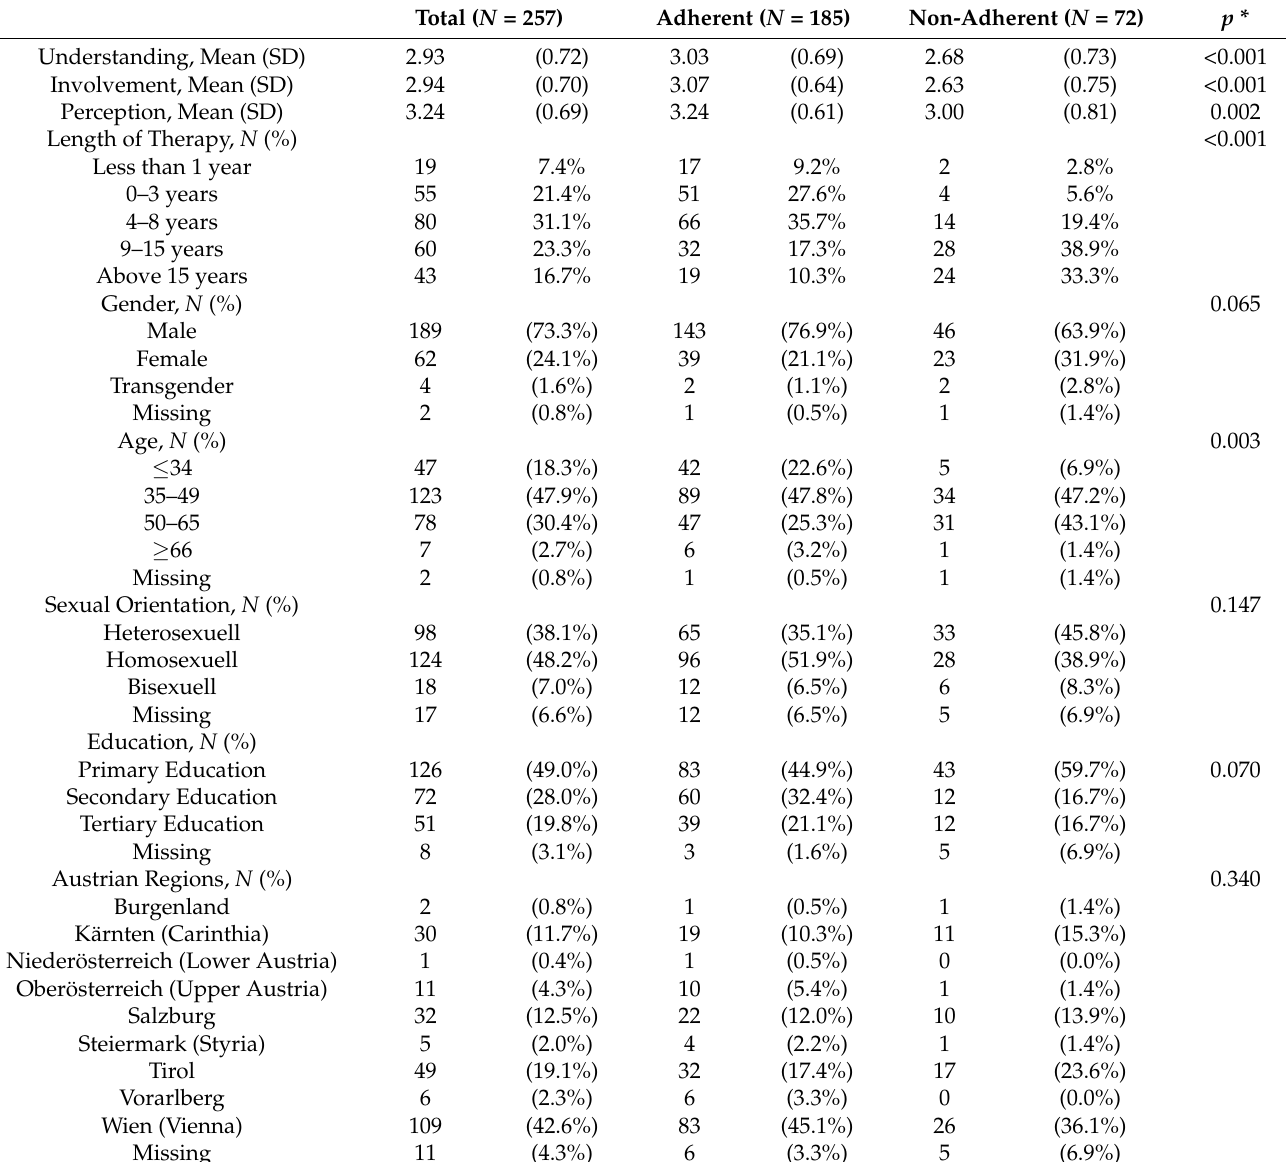
Table 1. Descriptive statistics on sample characteristics and inference statistics for group comparison between adherent and non-adherent